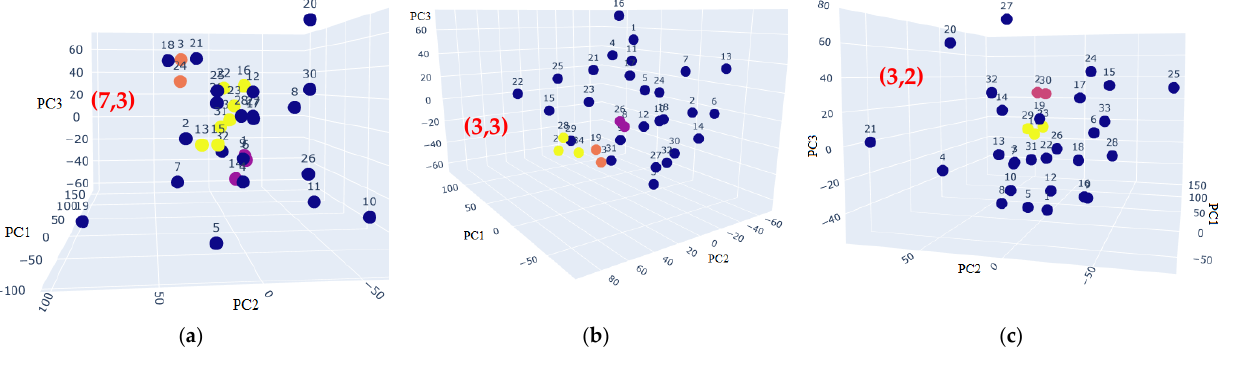
Figure 7. PCA clustering arranged according to the maximum points in their clusters identified by DBSCAN for Al from tighter ( a ) to wider ( c ): ( a ) P Max -Aluminum; ( b ) P Min -Aluminum; and ( c ) P Med -Aluminum where PC1: first principal component; PC2: second principal component; and PC3: third principal component of PCA analysis. The different colored dots (yellow, orange and purple) regarding founded clusters by DBSCAN and the numbers in red: (Maximum points in clusters, number of clusters) of these clusters.